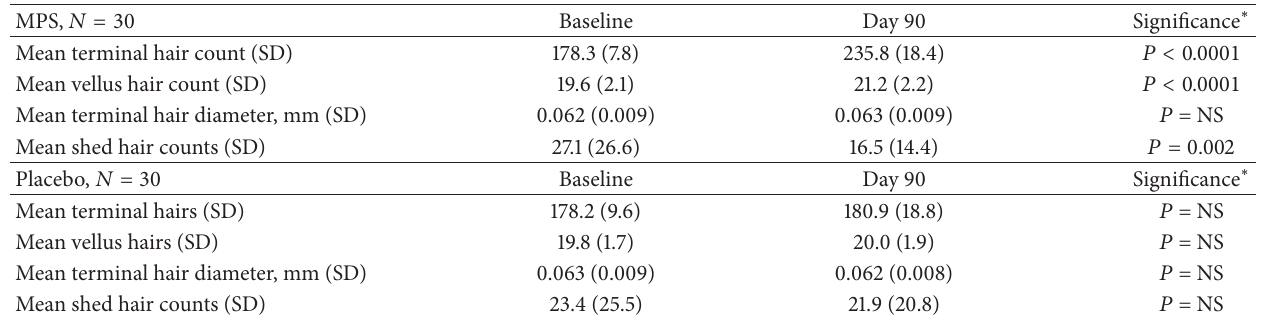
Table 1: Changes in hair growth and hair diameter.